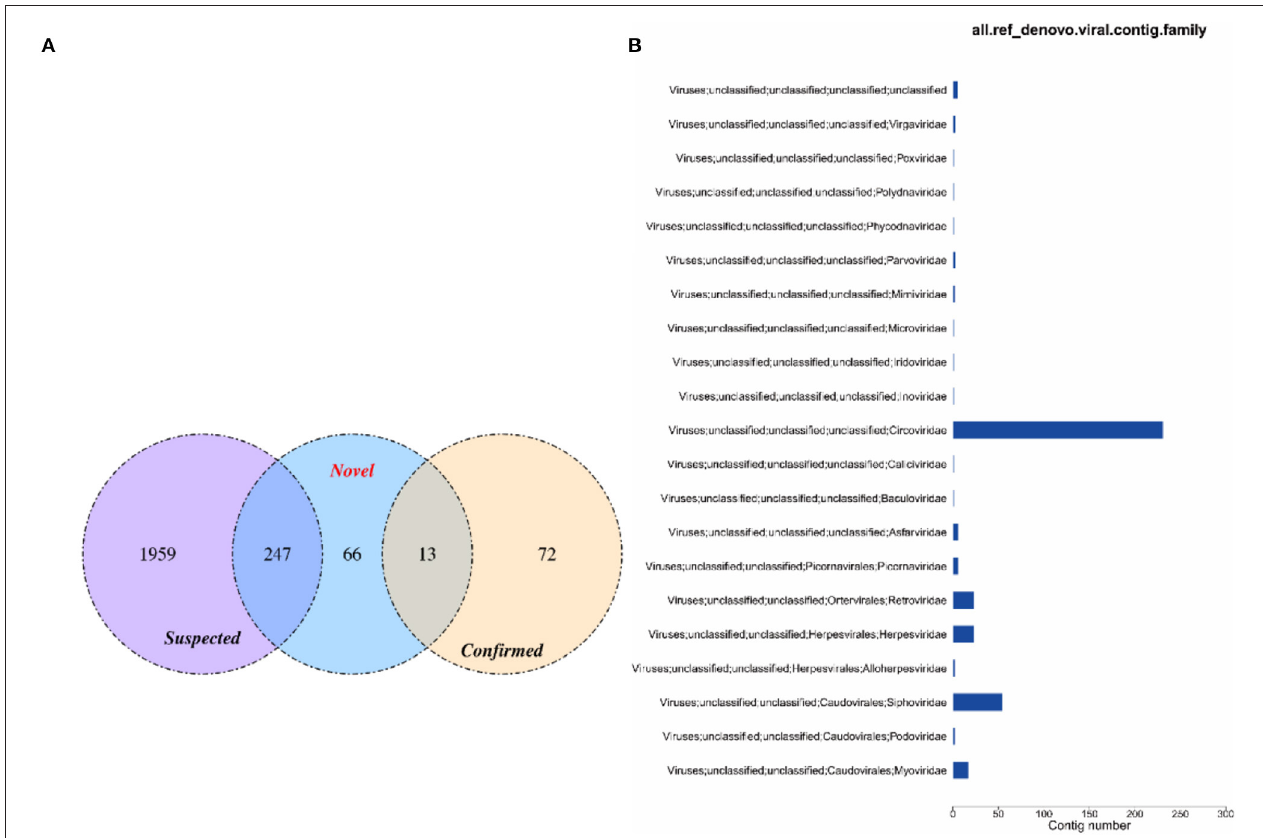
FIGURE 6 | Venn and annotated statistical diagrams of the virus sequence. (A) Comparison of the number of contigs obtained by different methods. (1) Novel method to obtain virus sequence; (2) Confirmed: confirmed virus sequence; (3) Suspected sequence of a virus. (B) Statistics of final viral sequence annotations (family level).